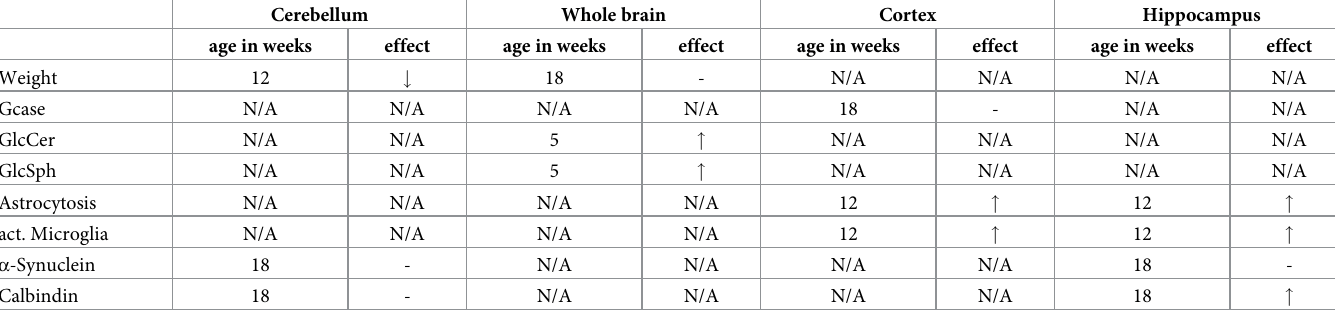
Table 4. Summary of quantitative neuronal changes in 4L/PS-NA mice compared to control animals. Cerebellum age in weeks